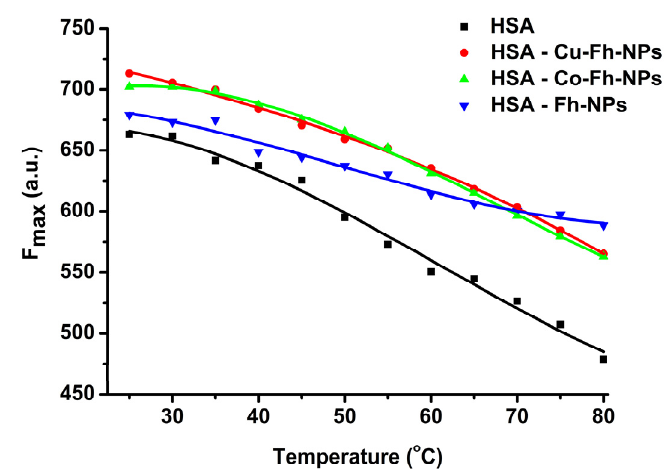
Figure 4. Profiles of thermal induced unfolding of HSA (black), HSA-Fh-NPs (dark cyan), HSA-Co-Fh-NPs (blue) and HSA-Cu-Fh-NPs (red), monitored by fluorescence emission ( λ ex = 295 nm). HSA (2.5 µM) was dissolved in 100 mM HEPES, at pH 7.25.